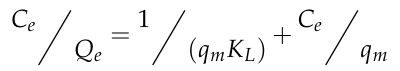
9 Figure 8. Binding kinetics of Cr VI adsorption onto MgAl-NO 3 LDH. In ( a ), the experimental data are fitted with a pseudo second-order kinetic model, whilst in ( b ), the experimental data are fitted with a pseudo first-order kinetic model.